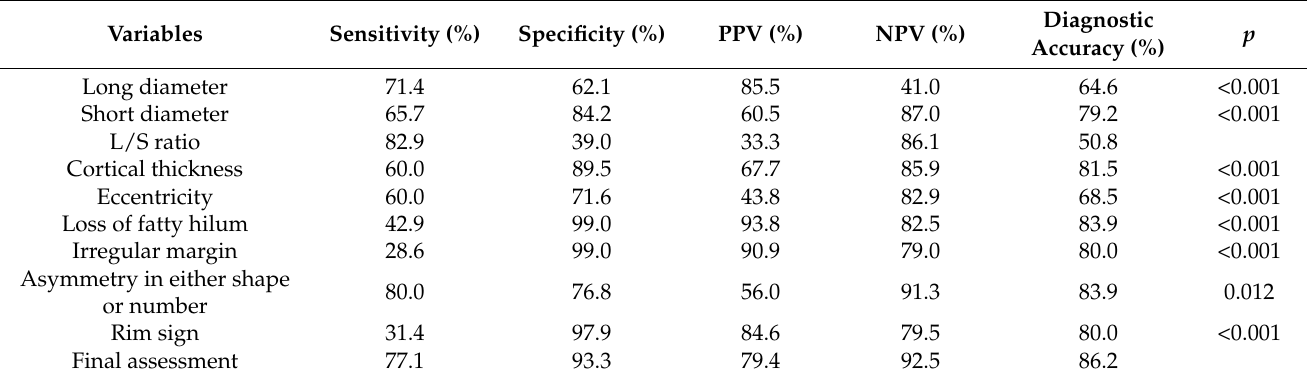
Table 5. Sensitivity, specificity, PPV, NPV, diagnostic accuracy, and p -value of the following